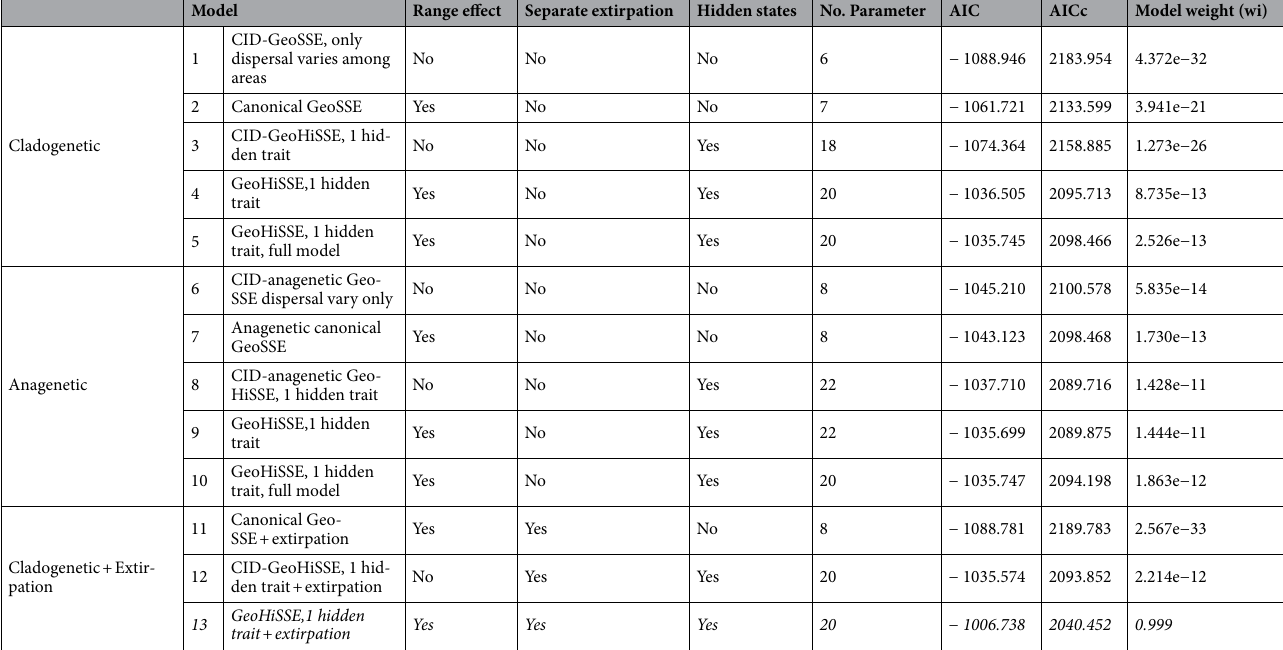
Table 2. Estimated diversification rates models evaluated in the GeoHiSSE framework.